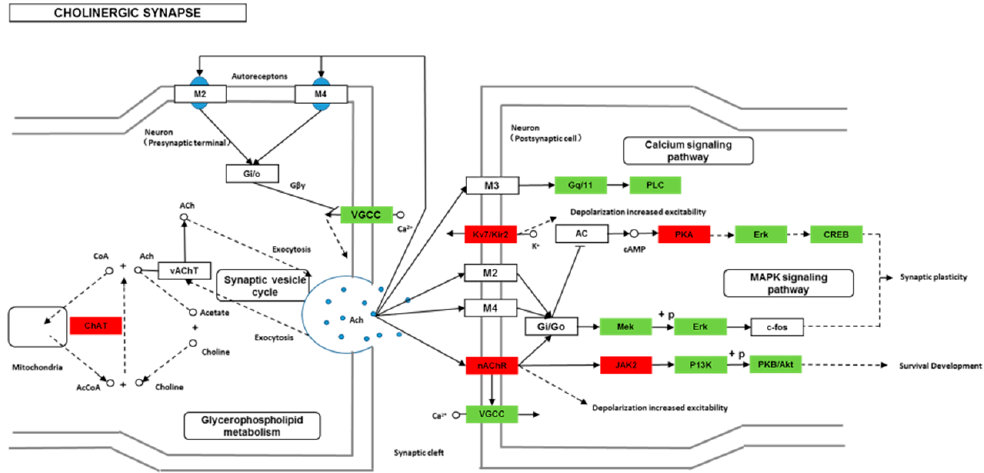
Figure 11. Di ff erentially expressed genes in the cholinergic synapse between mandarin fish in the control group (CG) and the learning group (LG) from a transcriptome analysis. The colors of rectangles were shaded according to the di ff erent expression (red: The mRNA expression levels of fish in Group LG were significantly higher than those in Group CG (FDR ≤ 0.001, the absolute value of log2 (Ratio) ≥ 1); green: The mRNA expression levels of fish in Group LG were significantly lower than those in Group CG (FDR ≤ 0.001, the absolute value of log2 (Ratio) ≥